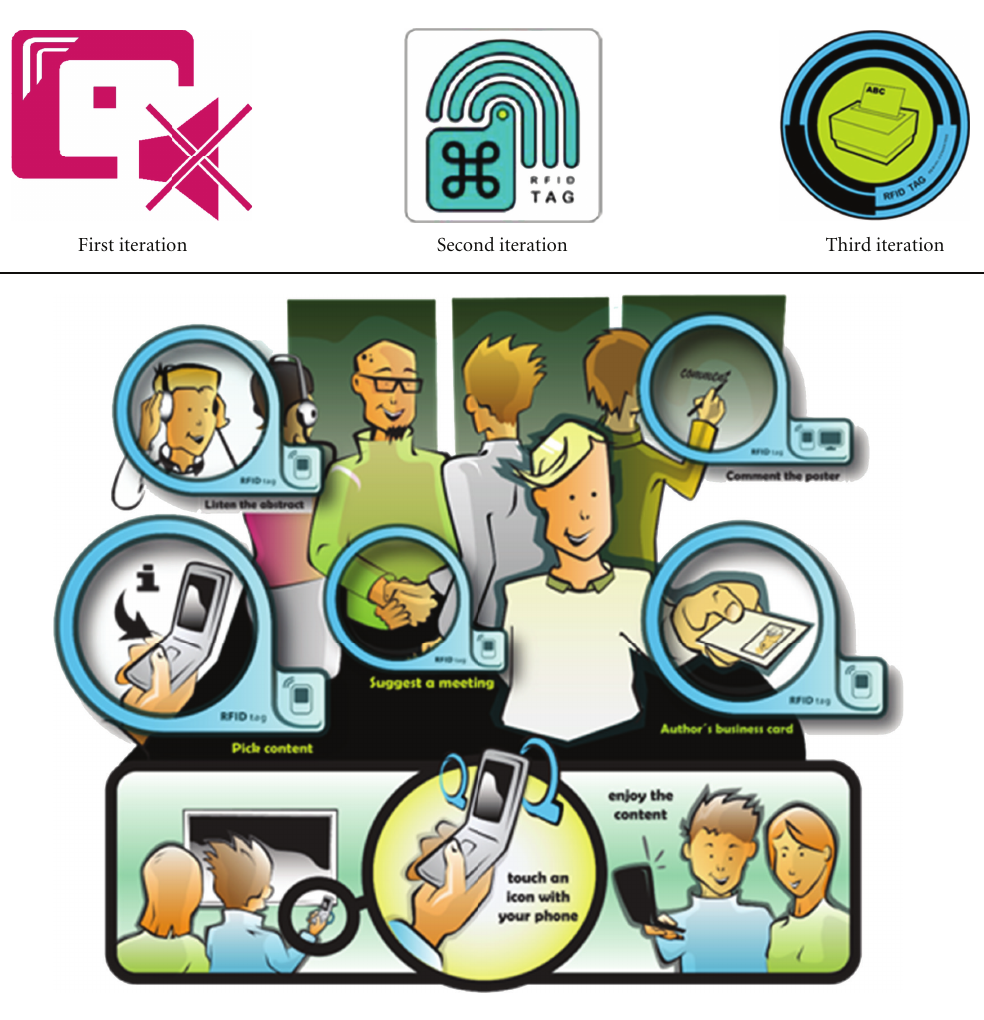
Figure 3: Examples for advertising NFC tags published in our previous